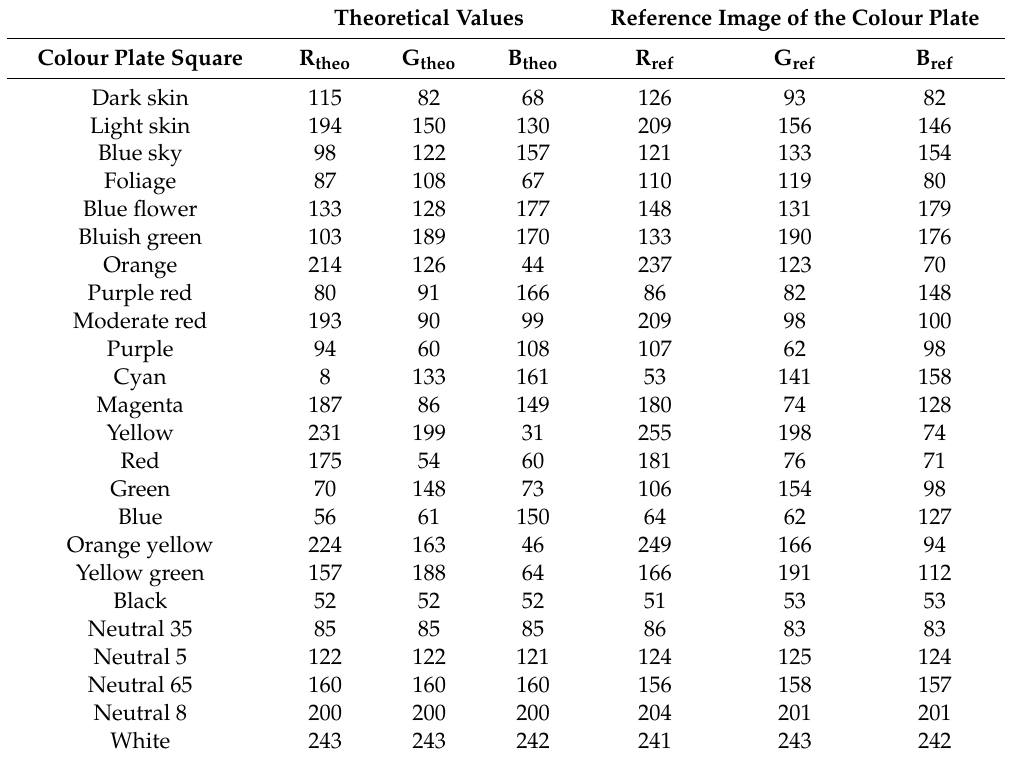
Table A1. Theoretical and reference RGB values of the colour squares of the colour plate. As expected, the reference RGB values of the colour squares are relatively far from the theoretical ones, the photograph of the colour plate having been taken with noncalibrated light and cameras, and colour plate having been printed with noncalibrated printer. These di ff erences have no influence on the CaliPhoto